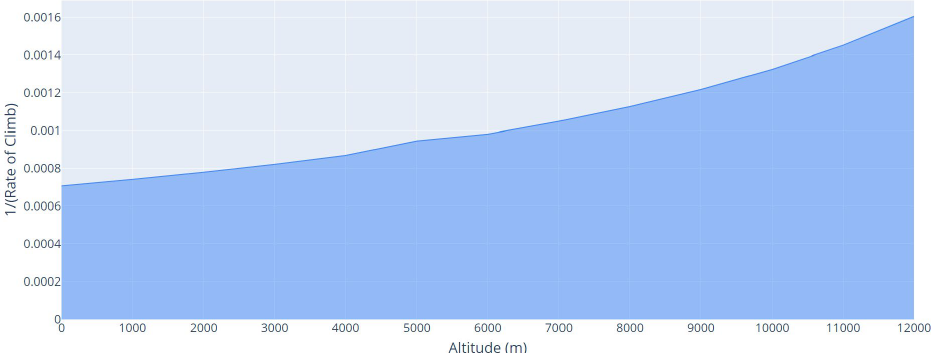
Figure 7. ( R / C ) − 1 versus altitude curve. Takeoff altitude = 0 m, cruise altitude = 12,000